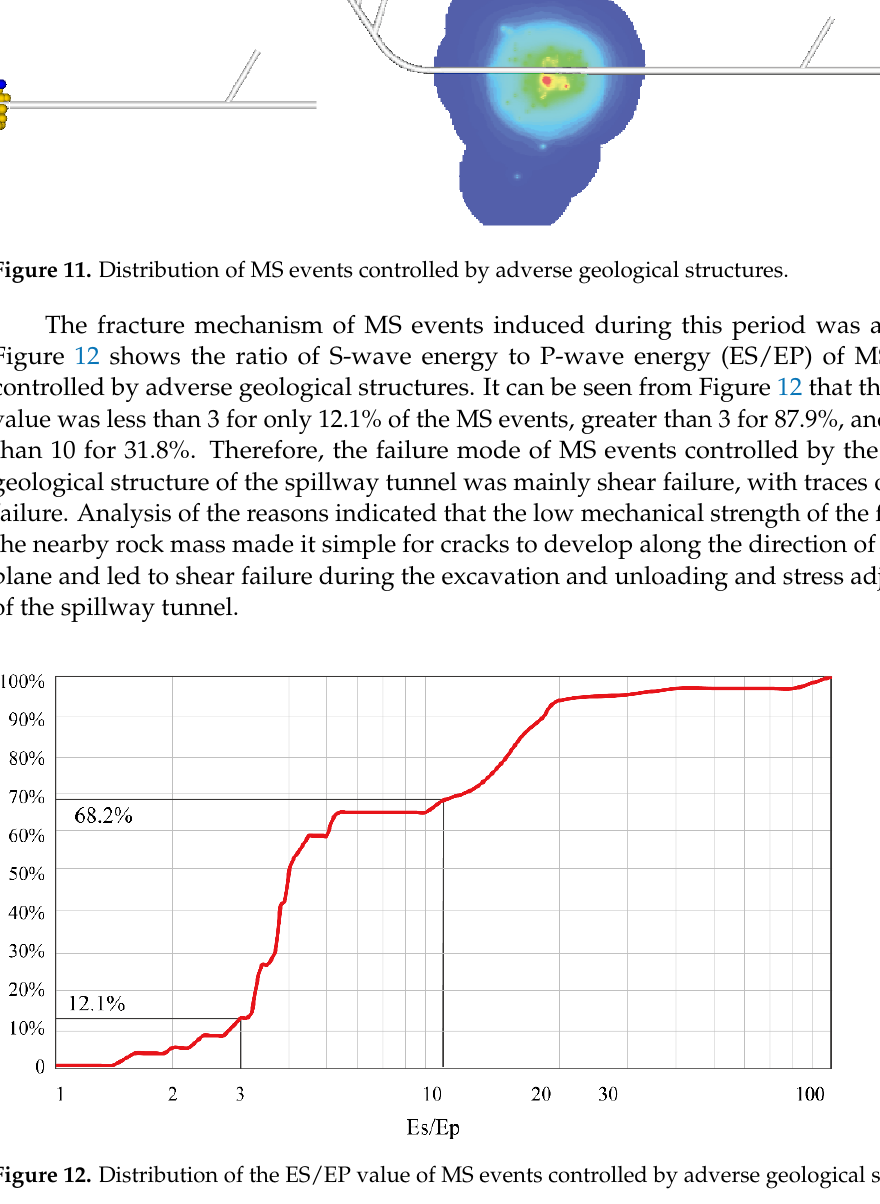
Figure 13. Monitoring data of the bolt stress meter (stake 0+457 m).